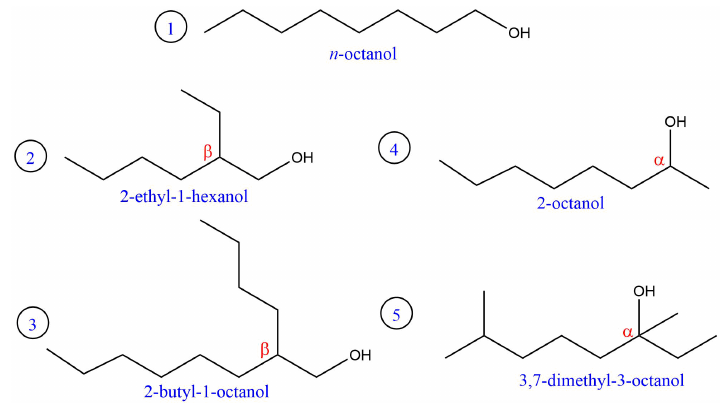
Figure 1. Structural formulas of extractants tested in this